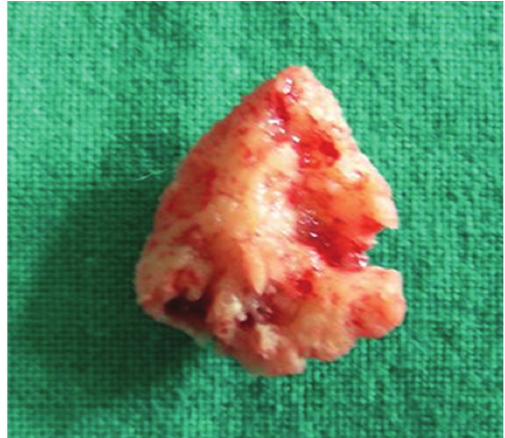
Figure 5: Excised specimen.